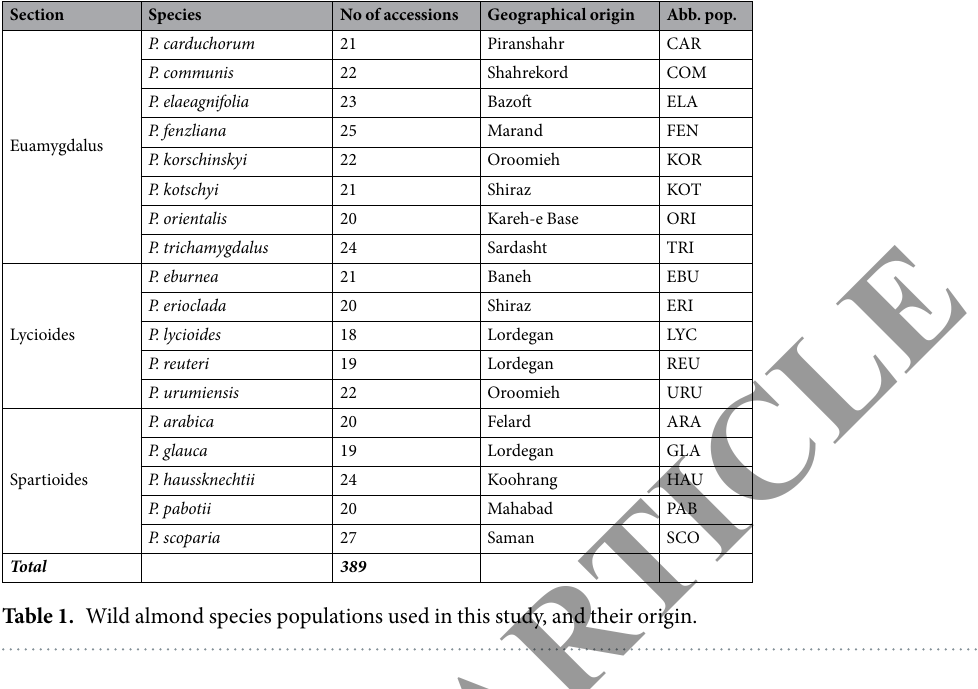
The characteristics of amplified IRAP loci using 19 primers are displayed in Table 3. The percentage values of IRAP polymorphic loci in population ranged from 47.6 (FEN) to 89.6 (KOT), with an average of 80.44. The fre- quency of all IRAP amplified loci was greater than 5%. A genotype-specific locus was generated in the population CAR by IRAP primer combination Tms1Ret1-LORE1. Primer LORE2 amplified a specific locus in a genotype of population EBU. Mean heterozygosity varied from 0.208 (ORI and SCO) to 0.261 (CAR), averaging 0.234 (Supplementary Table S1). REMAP analysis. Of the 48 REMAP primer combinations investigated, 34 produced 391scorable bands. The primer combination Tms1Ret1-A7 created a monomorphic banding pattern. No bands were amplified using REMAP primer combinations with RTN Tps19. Of the391 amplified bands, 300 were polymorphic (71.2%) (a representative banding pattern is shown in Fig. S2). The average number of polymorphic bands was 8.82 per primer. The size of the amplified fragments varied from 100 to 2,500 bp. There were three well-known important clusters, based on REMAP data (Fig. 2). Group I consisted of two subgroups: CAR, COM, ELA, FEN, KOR and KOT in subgroup I, and ORI and TRI in subgroup II; the species belonging to the Lycioides section were grouped in group II. The third group consisted of the populations REU, GLA, HAU, PAB, and SCO. Associations between 18 populations using REMAP markers were well-established through PCA (data not shown). REMAP-based AMOVA was approved using the 18 populations for the basis of the analysis. Similar to the results acquired by the IRAP method, the level of genetic variation was higher between populations (92%) compared to within populations (8%), demonstrating clear discrimination of the studied populations. The characteristics of amplified loci by means of 34 REMAP primers are shown in Supplementary Table S1. The percentage of polymorphic loci in a population based on REMAP data varied from 63.2 (KOT) to 88.6 (KOR), with an average value of 78.9. Two loci with a frequency of less than 25% were detected (Supplementary Table S1), suggesting that most of the amplified loci are common in the studied populations. Nine genotype-specific REMAP loci were identified in populations KOR, KOT, TRI, ERI, URU, ARA, HAV, PAB and SCO. The mean of heterozygosity varied from 0.221 (HAU) to 0.275 (FEN), with an average of 0.267. Combined data IRAP and REMAP analysis. The combined data of IRAP and REMAP markers were utilized to construct a dendrogram to calculate the influence of both techniques when taken together. Populations were assembled into three most important clusters (Fig. 3). Group I included COR, COM, ELA, KOR, KOT, ORI and TRI. Populations EBU, ERI, URU, ARA and LYC clustered in group II and REU, GLA, HCU, PAB, and SCO were classified into group III. A PCA of the IRAP + REMAP data was used to validate associations between eighteen populations. The first (PCA1) and second (PCA2) principle coordinates accounted for 33% and 21% of the total variation, respectively. Relationships between populations on the biplot were similar to the results acquired from cluster analysis. AMOVA was carried out to investigate total genetic variation between and within populations. Similar to that shown by IRAP and REMAP markers, the level of genetic variation was higher between populations (83%) compared to within populations (7%). The percentage of polymorphic loci in populations varied from 78.5 (TRI) to 86.35 (HAU), with an average of 81.9. The mean of heterozygosity varied from 0.206 (SCO) to 0.272 (TRI), with an average of 0.242 (Supplementary Table S1). Due to high genetic diversity between popula- tions, IRAP + REMAP-based cluster analysis was carried out using complete linkage algorithms based on simple matching (SM) similarity coefficient to recognize groups among all 389 wild almond accessions.